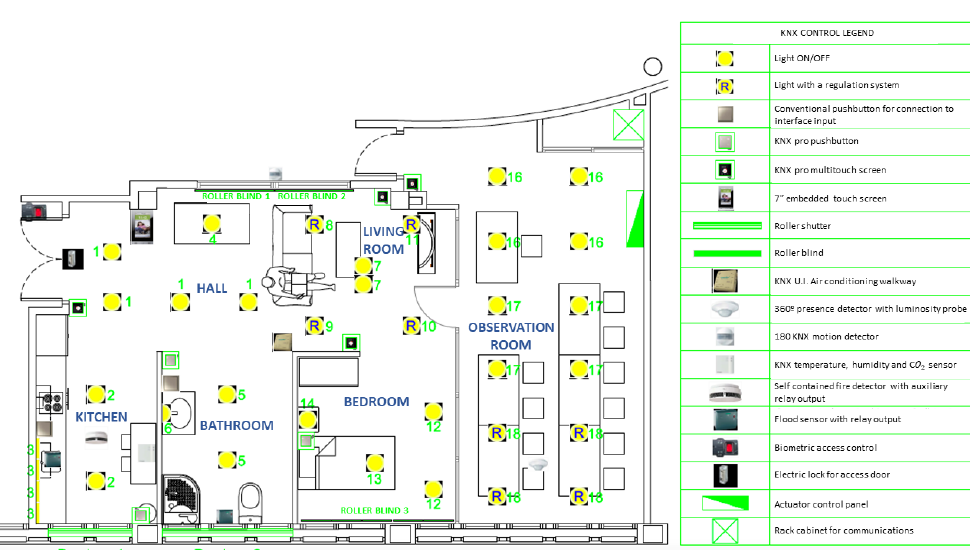
Figure 6. Initial distribution plant of Smart Home of